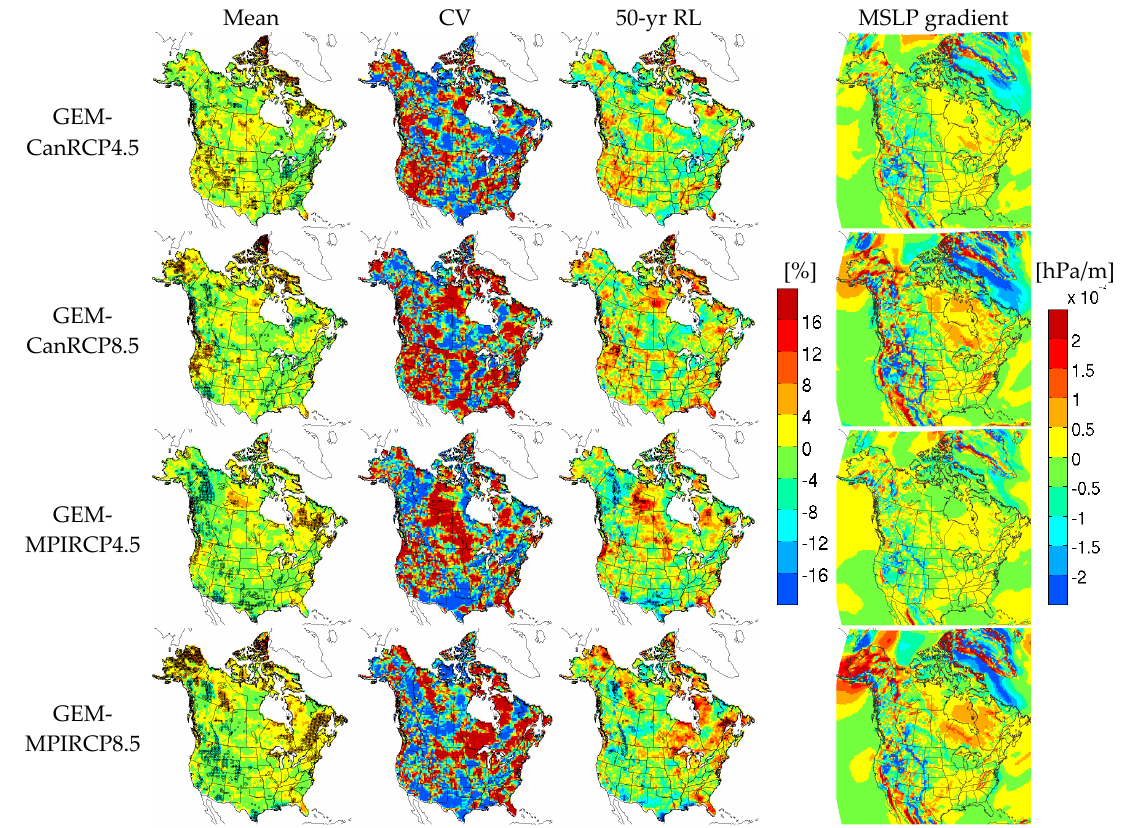
Figure 7. Projected changes to the mean, coefficient of variation (CV), and 50-year RL of annual maximum wind speed for the future 2071–2100 period with respect to the current 1981–2010 period. Grid points are marked by open circles when the mean and 50-year return period values for current and future periods are statistically different at the 10% significance level. Projected changes to annual MSLP gradient are provided in the fourth column.